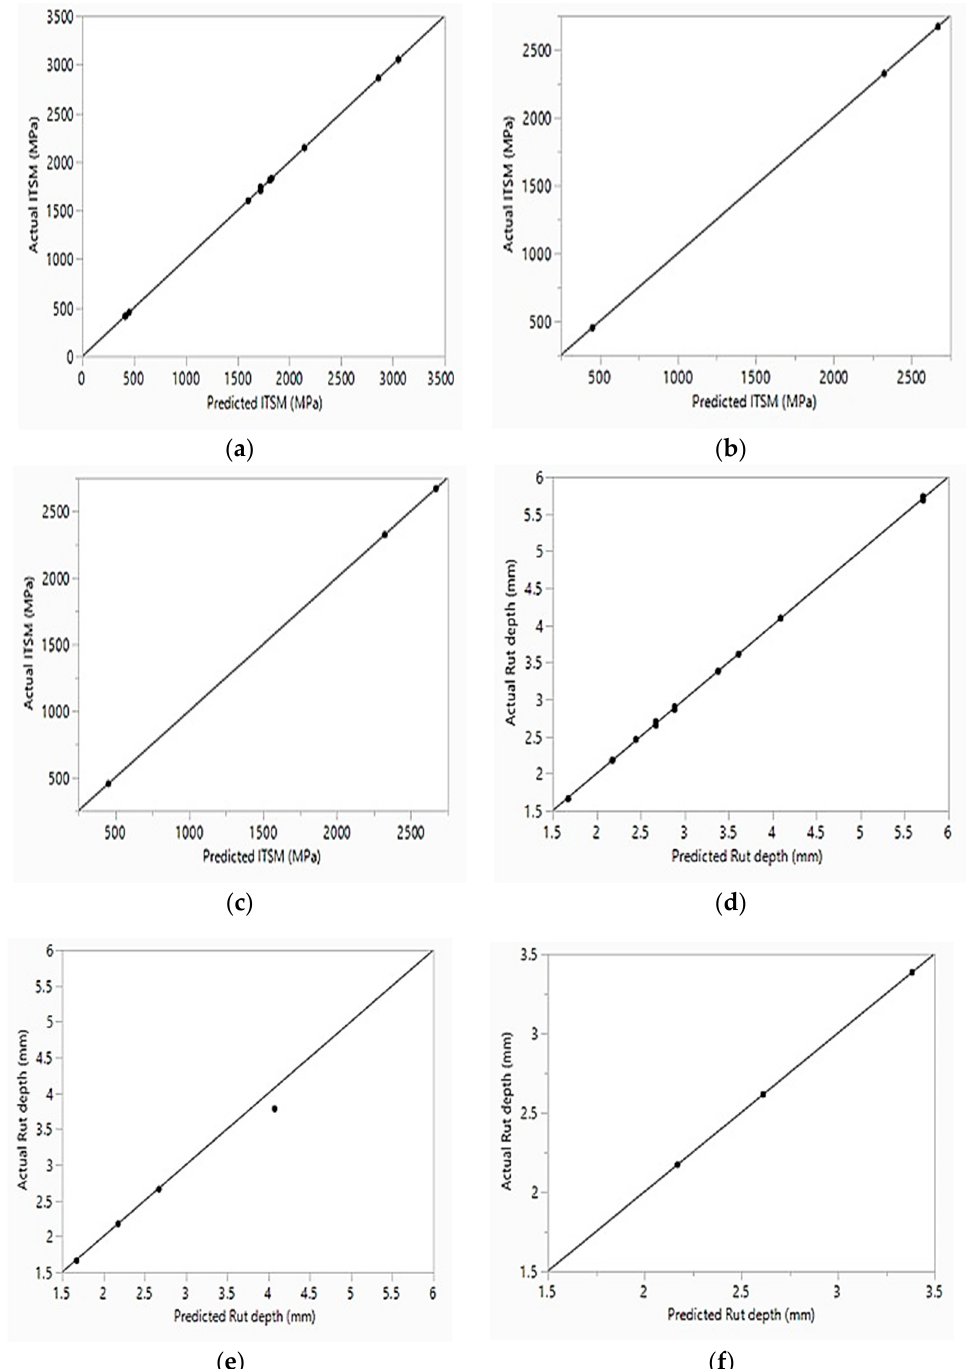
Figure 17. ANN model actual vs. predicted for the response stiffness modulus: ( a ) training, ( b ) validation, ( c ) testing and the response rutting depth, ( d ) training, ( e ) validation, ( f ) testing.